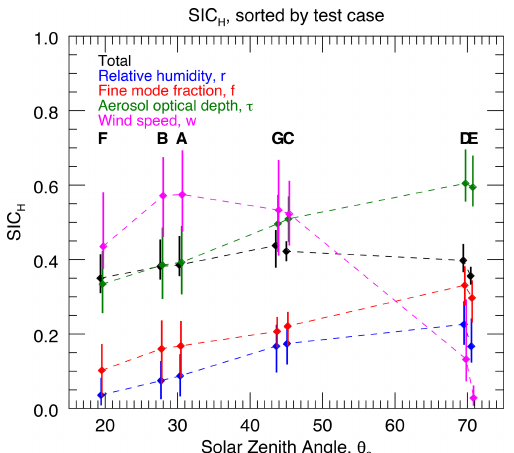
Figure 6. SIC H sensitivity to sun and observation geometry. Median SIC H values for all cases with the specified solar zenith angle ( θ s ) are plotted with diamonds connected by dashed lines. Vertical bars indicate the inter-quartile range. The total SIC H is in black, while the marginal SIC H values for r , f , τ , and w are plotted in blue, red, green, and magenta, respectively. Letters showing test case geom- etry are also shown. To aid legibility, in some cases we offset the marginal SIC H θ s values slightly (less than 1 ◦